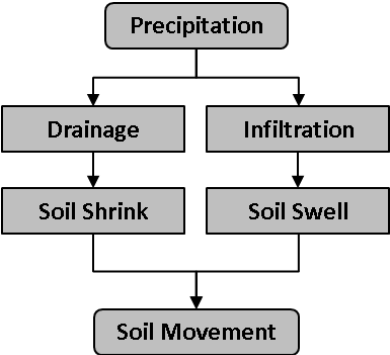
Figure 2. Influence of precipitation on soil